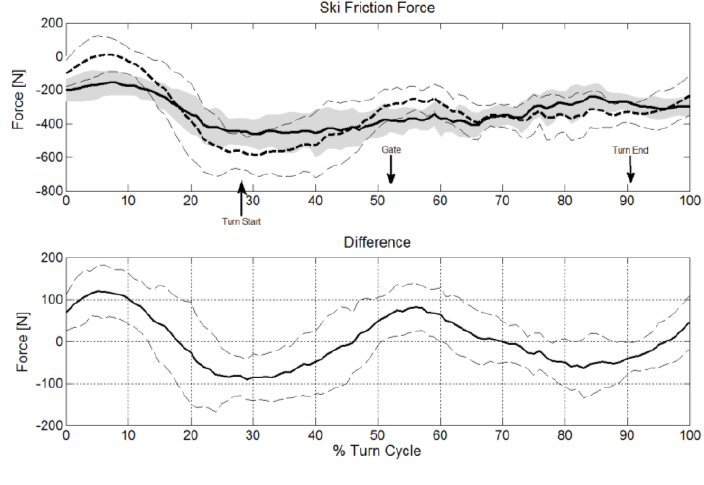
Figure 5. Comparison of the ski friction force computed from the dGNSS method ( F , solid line) and the reference system ( F , thick dashed line) with their F,dGNSS F,REF standard deviation ( F , gray area; F , thin dashed lines) is provided in the upper F,dGNSS F,REF part of the graph. The bottom part of the graph shows the instantaneous average vectorial difference (solid line) and instantaneous AVD-Within-SD (dashed lines) across the turn cycle. Gate passage and the points where the turn radius is less than 30 m are marked as turn start and turn